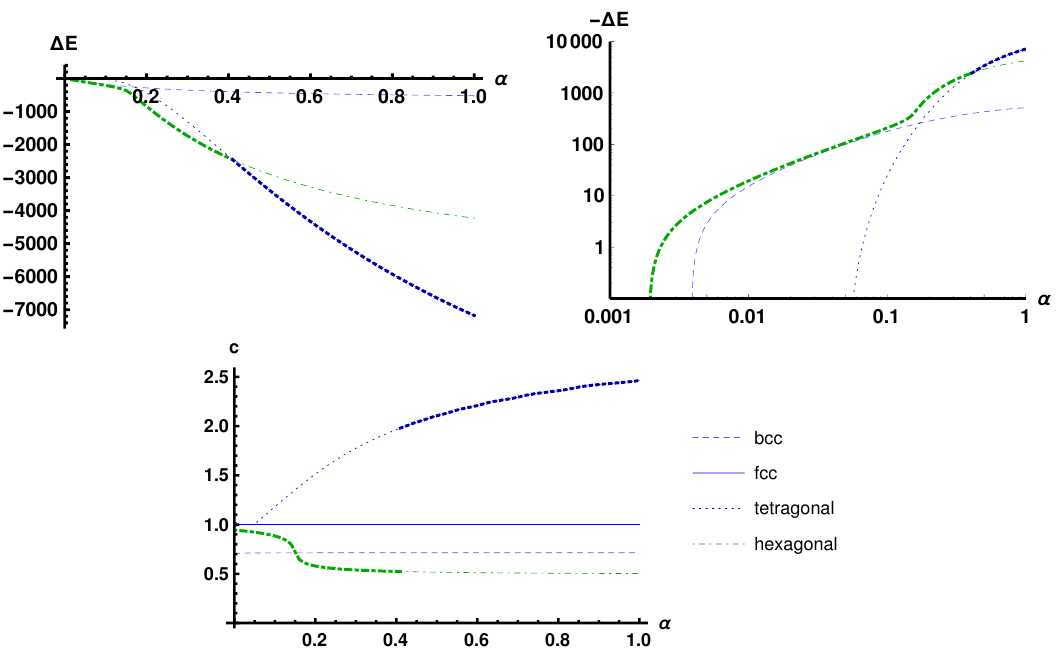
Figure 13: The non-Abelian crystals for 0 < α = β < 1. Top row: the energy differ- ence of different phases with respect to the fcc configuration as a function of α . Bot- tom row: the aspect ratios as a function of α . Blue colors indicate cubic / tetragonal lattices, fig. 9 (a) , and green colors are hexagonal, fig. 9 (c) . In more detail, the solid blue, dashed light blue, and dotted dark blue curves are the results for the fcc, (near) bcc, and tetragonal large- c lattices, respectively, whereas the dot-dashed green curves show the result for the hexagonal lattices. Dominant phases are shown as thick curves and subdominant as thin